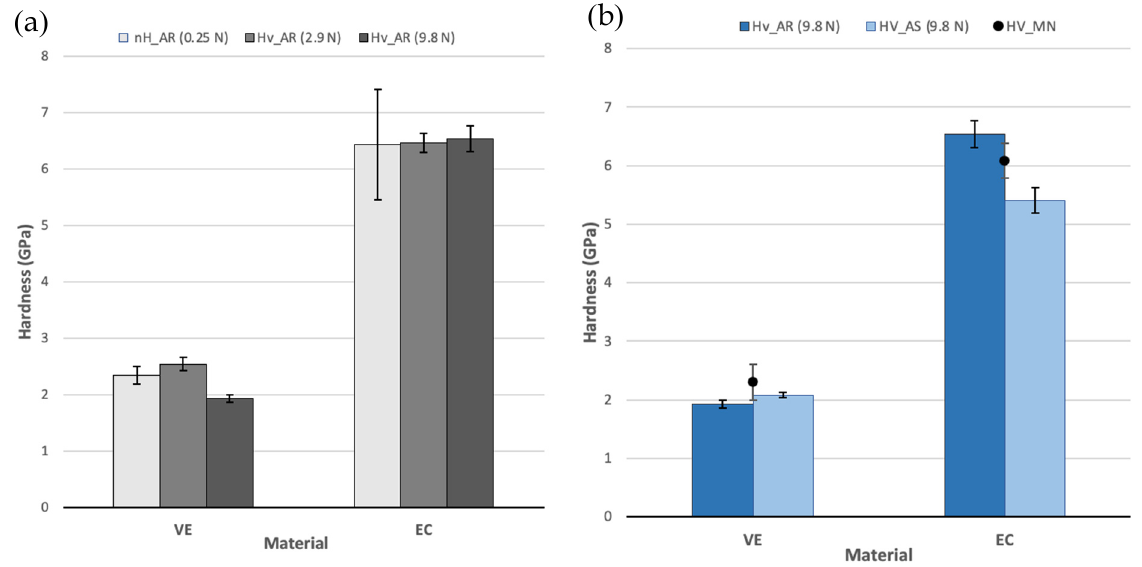
Figure 6. Micro- and nano-hardness (mean and standard error) for VE and EC ( a ) Influence of the applied load and the test method on AR specimens; ( b ) influence of the saliva immersion (AS) and the comparison with the manufacturer (MN) data.